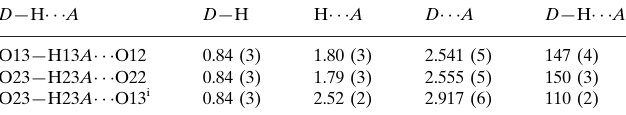
Hydrogen-bond geometry (A˚ , (cid:3) ). D —H (cid:2)(cid:2)(cid:2)